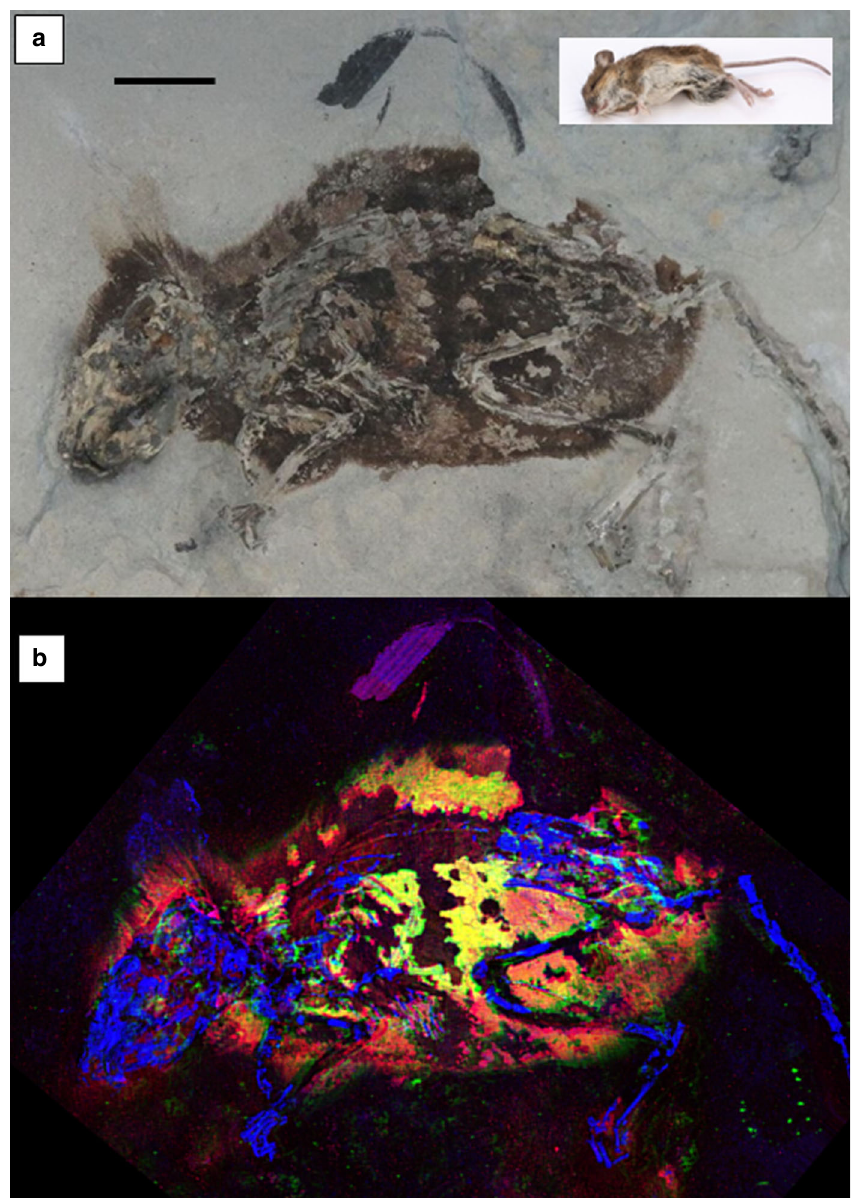
Fig. 1 Optical and X-ray images of Apodemus atavus “ lateral ” fossil. a Optical image of “ lateral ” fossil A. atavus (GZG.W.20027b) with the inset of extant A. sylvaticus in the upper right for comparison (scale bars = 1 cm). b False-color SRS-XRF image reveals exceptional preservation of integument as well as bone. This image is a combination of three maps, two standard single-element maps (blue = P, green = Zn), plus a third map which has been produced to especially emphasize the distribution of a speci fi c oxidation state of organic sulfur (red = S in thiol) in order to highlight the clear correlation between the distribution of Zn and organic sulfur which together appear as bright yellow. (Optical photograph by